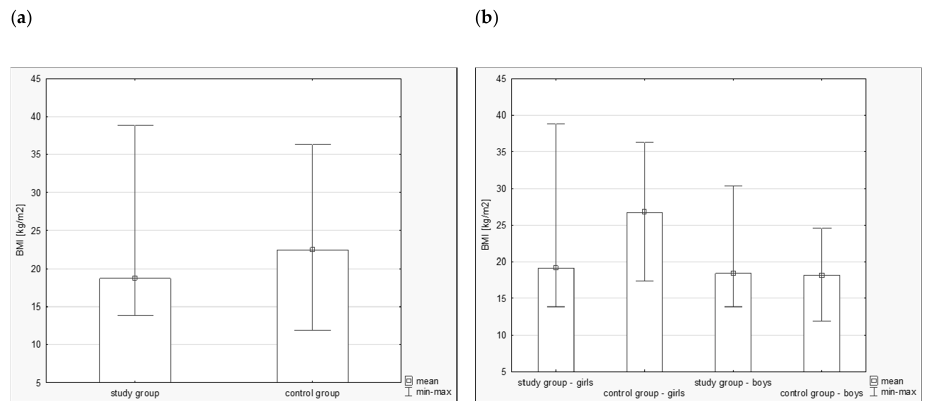
Figure 1. The mean body mass index—BMI [kg/m 2 ] in the study groups. ( a ) study group vs. control group, ( b ) groups according to sex.